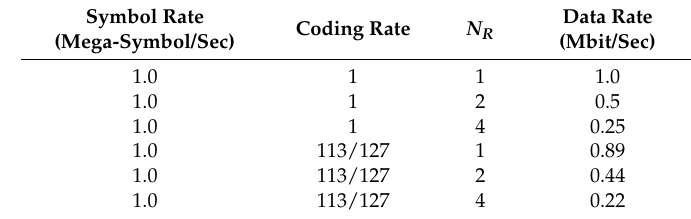
Figure 4. PPDU repetition.